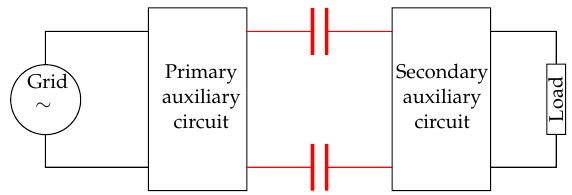
Figure 3. Capacitive power transfer